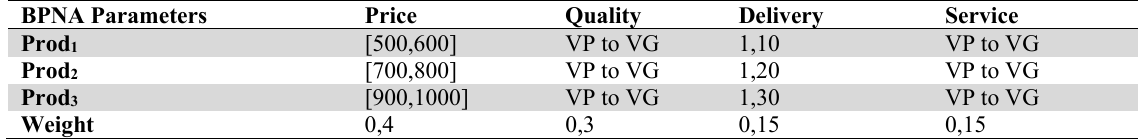
BPNA Negotiation issue value ranges & weight